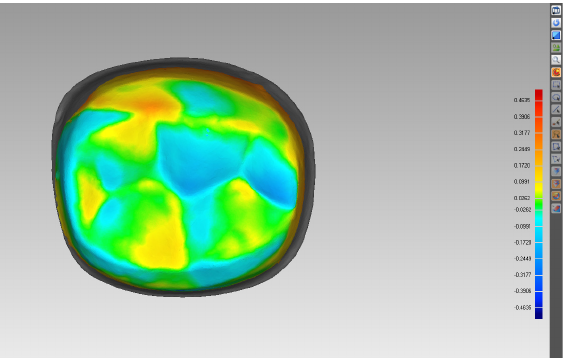
Figure 6. Measurement of the average distance between the scanned data and predesigned prepa- ration data.